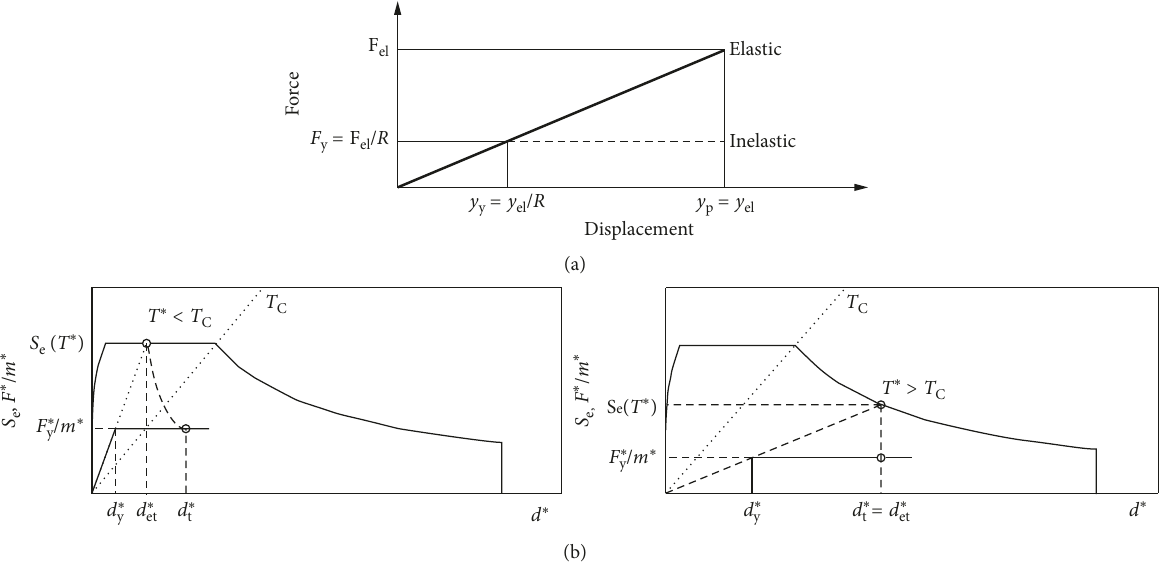
Figure 1: (a) Schematic description of the equal displacement rule (EDR). (b) ADRS representation of the nonlinear displacement demand according to EC8 (adapted from